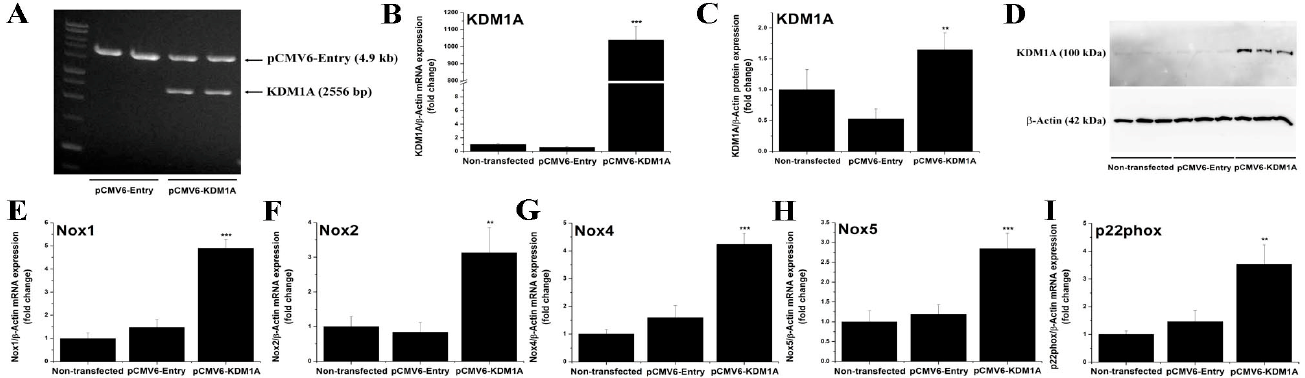
Figure 10. Overexpression of LSD1 triggers the up-regulation of Nox1, Nox2, Nox4, Nox5, and p22phox transcript levels in HEK293 reporter cells. ( A ) Agarose gel electrophoresis (1%) depicting the digestion products of the pCMV6-Entry and pCMV6-KDM1A expression vectors with SgfI/MluI restriction enzymes. Note the release of a ≈ 2.5 kb DNA fragment corresponding to human LSD1 (KDM1A) open reading frame following pCMV6-KDM1A enzymatic digestion. Validation of LSD1 (KDM1A) ( B ) gene and ( C ) protein up-regulation following transfection of the HEK293 cells with pCMV6-KDM1A expression vector. ( D ) Representative immunoblot depicting the up-regulation of LSD1 protein in pCMV6-KDM1A-transfected HEK293 cells. ( E – I ) Real-time PCR-based gene expression analysis showing the induction of Nox1, Nox2, Nox4, Nox5, and p22phox transcript levels in HEK293 cells overexpressing the human LSD1 (KDM1A) gene. n = 3, ** p < 0.01, *** p < 0.001. p -values were taken in relation to pCMV6-Entry-transfected cell condition.